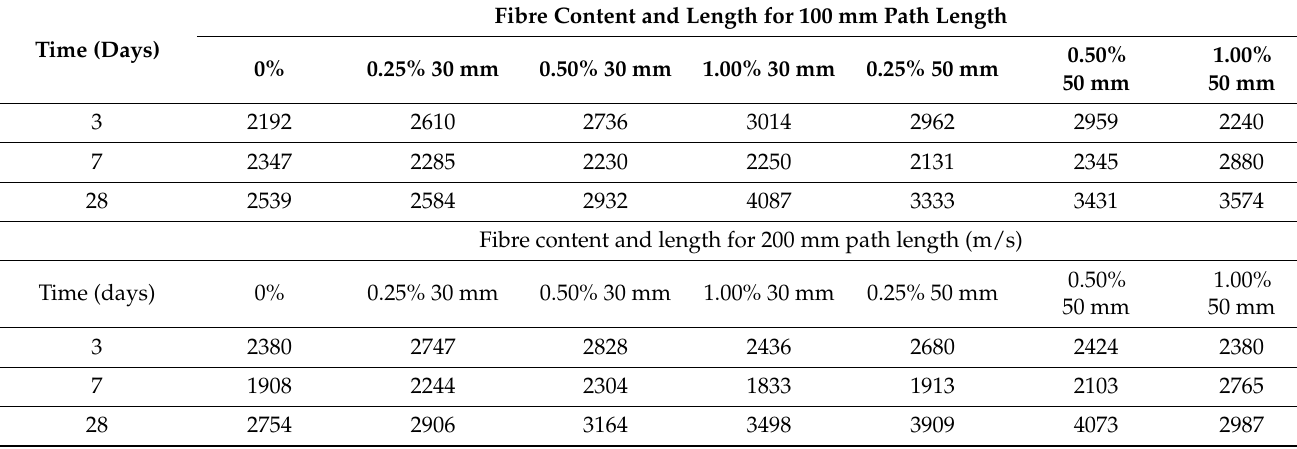
Figure 19. UPV indirect measurements with 200 mm path length. Table 7. Indirect UPV for different path lengths at 3, 7, and 28 days (m/s). Fibre Content and Length for 100 mm Path Length Time (Days) 0%